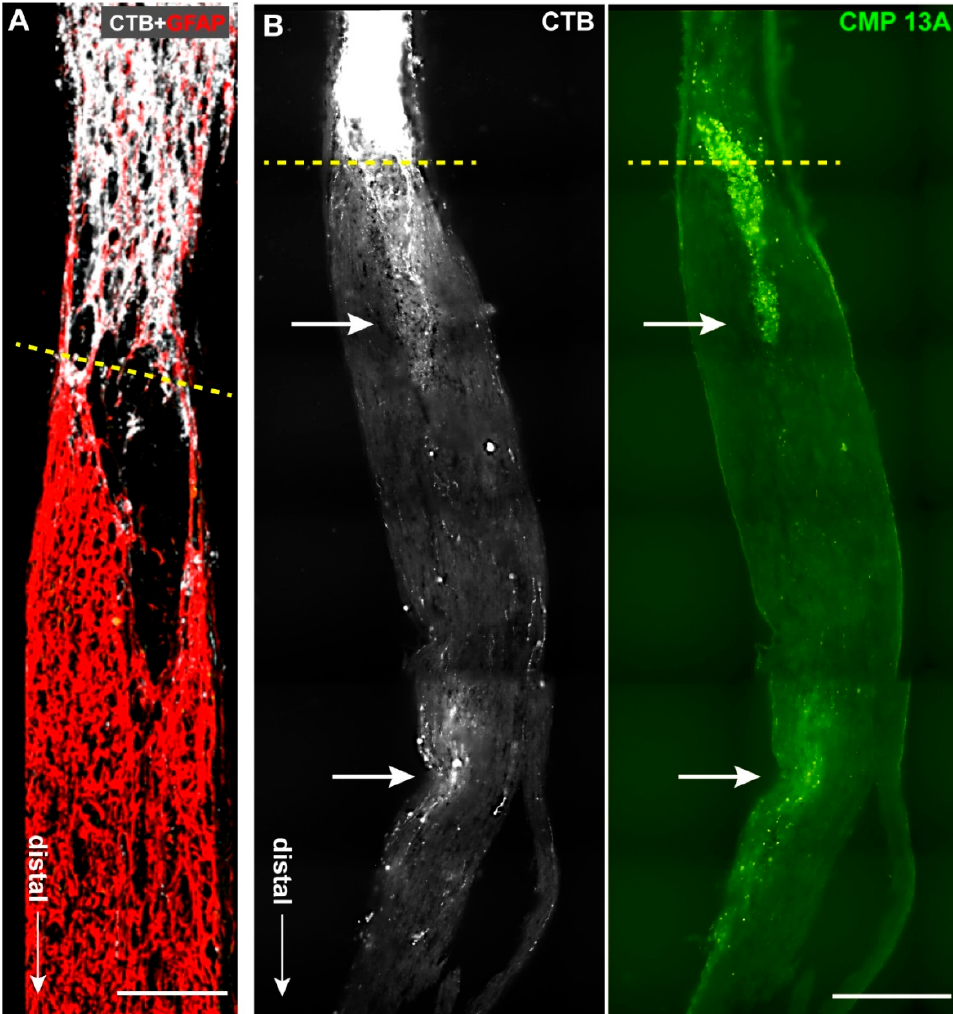
Figure 3. Collagen mimetic peptide promotes axon repair following nerve crush. ( A ) Stitched montage of confocal micrographs of longitudinal section through optic nerve two weeks following crush from eye receiving an intravitreal injection of vehicle (DMSO) three days after the injury. Axons containing cholera toxin B (CTB, false color white) extend to the site of crush (dashed line) but generally not beyond distally towards the brain (arrow). Astrocyte glia labeled for glial fibrillary acidic protein (GFAP, red) are shown for comparison. ( B ) In contrast, CTB-containing axons in section of nerve from eye receiving CMP 13A extend beyond the crush site and are apparent even at more distal locations along the nerve. Repaired axons are largely coincident with localized patches of CMP 13A (green), visualized through its attached chromophore (Tide Fluor™ 2, see Methods). Scale = 200 µm ( A ) or 100 µm ( B ).